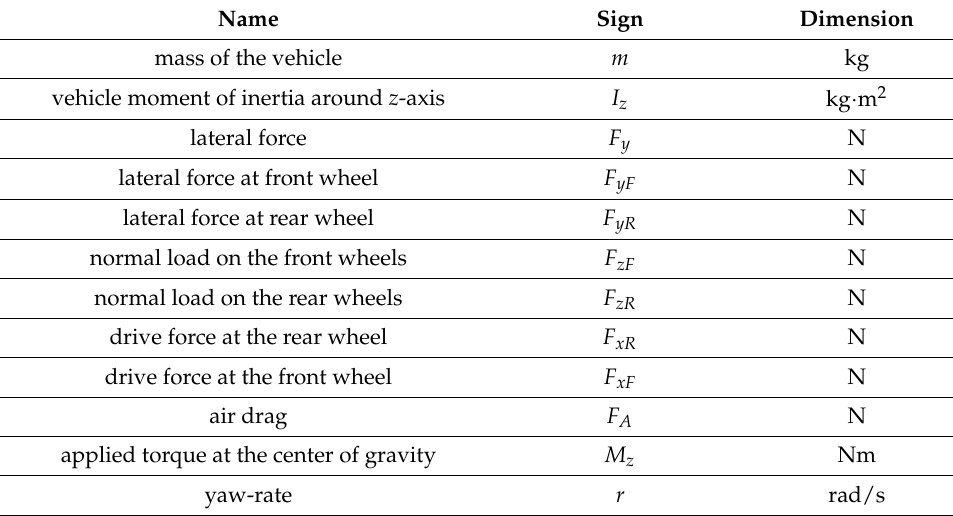
Table A1. Nomenclature: list of